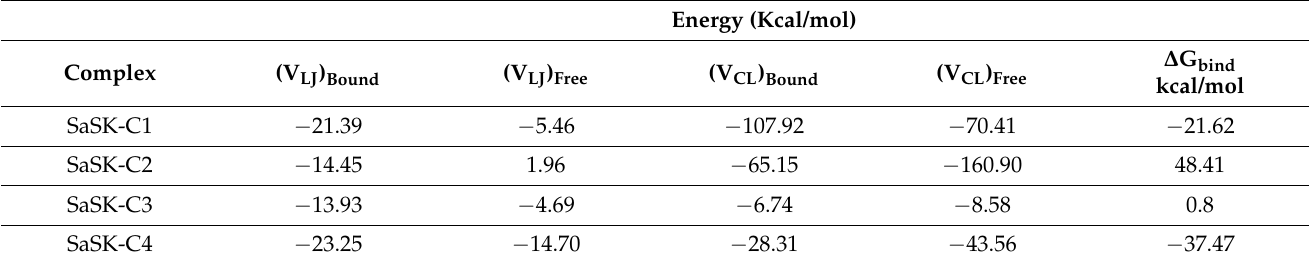
Table 3. Binding free energies calculated by the LIE method for each complex in MD simulation.